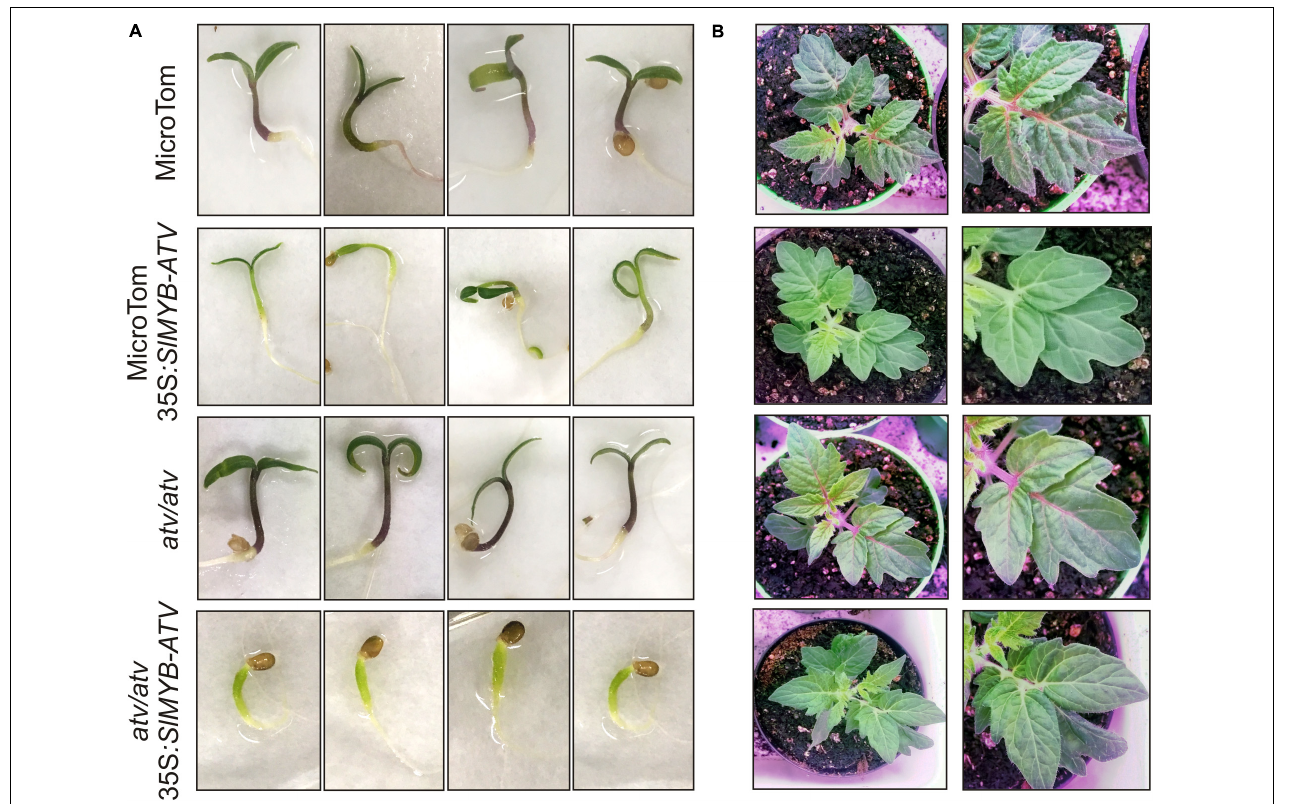
FIGURE 6 | Overexpression of SlMYB-ATV in tomato. Phenotype of (A) 1-week-old seedlings and (B) 4-week-old plants of MicroTom (MT), 35S: SlMYB-ATV in MT, atv / atv in MT background and 35S: SlMYB-ATV in atv / atv